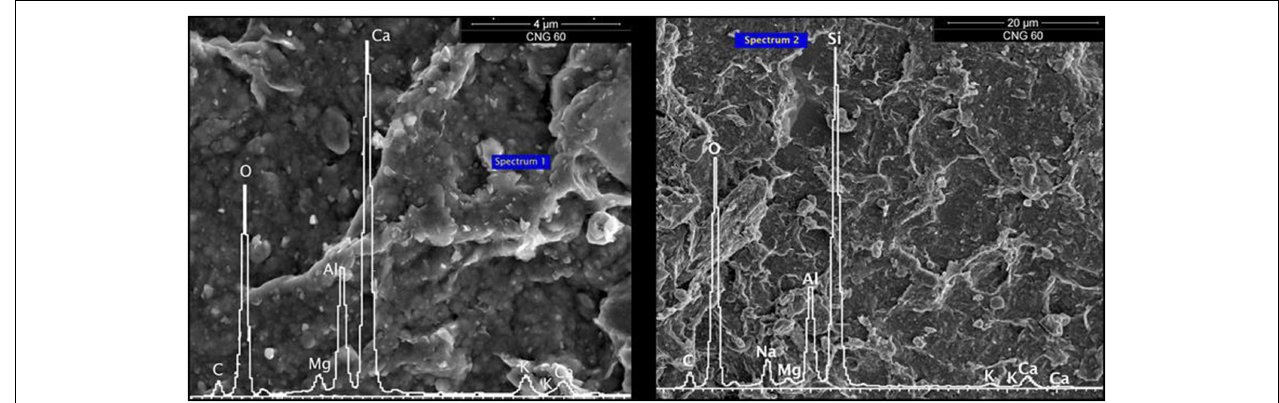
FIGURE 1 | SEM image and EDS spectra for CNG 60. “Spectrum” tag marks where EDS analysis was conducted.